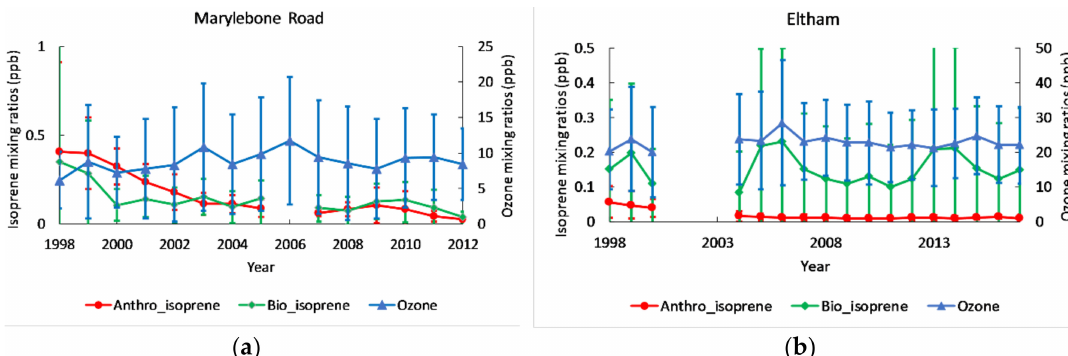
Figure 7. Trends in summertime anthropogenic isoprene, biogenic isoprene, and ozone over the time for ( a ) Marylebone Road, ( b ) Eltham. Note: There are no data for the period of 2001–2003 for Eltham and 2013–2017 for Marylebone Road. The isoprene data for 2006 at Marylebone Road is omitted because of the very limited isoprene data (only part of June month data available). The error bar represents ± 1 SD of the whole data